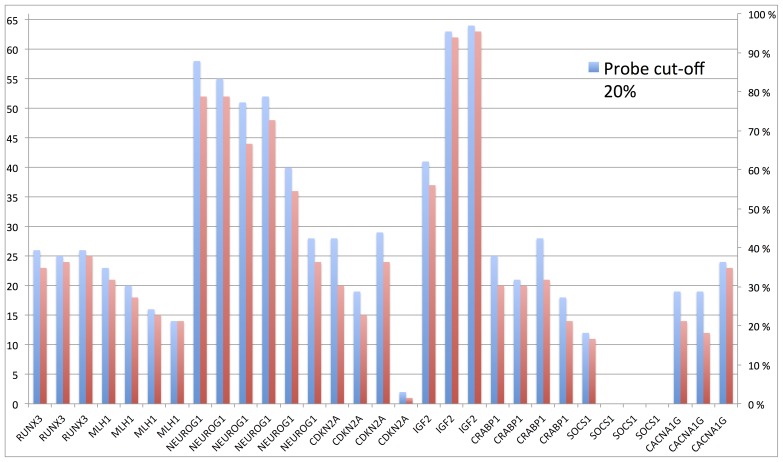
Scoring of methylated probes using a cutoff of 20% (red) and 30% (blue).The axis to the left shows the number of positive samples, and the axis on the right shows the percentage of positive samples.